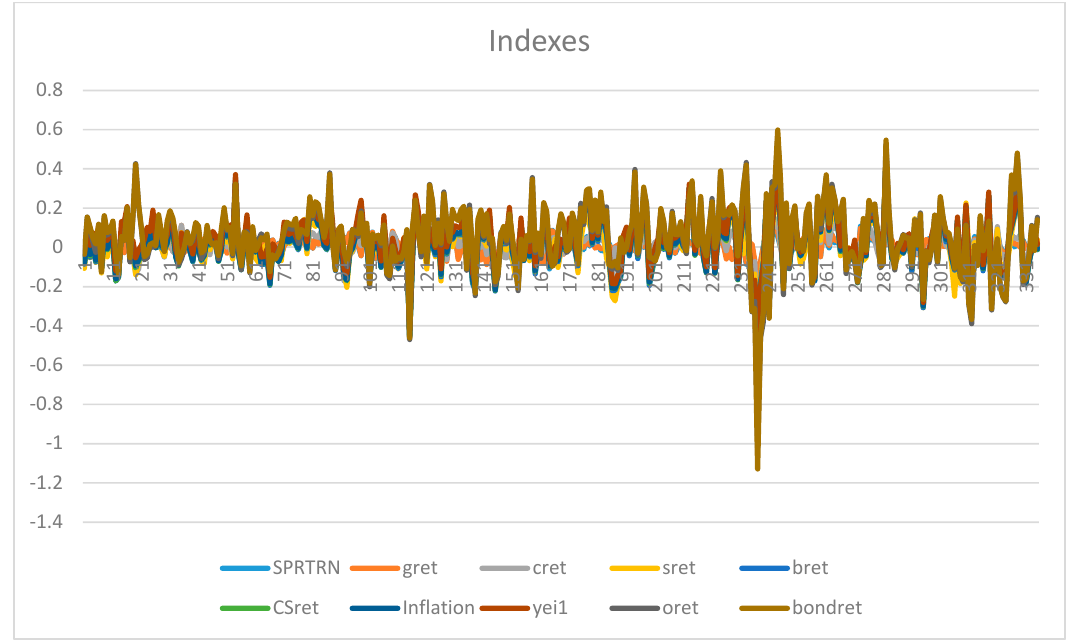
Table 2. Summary statistics table.